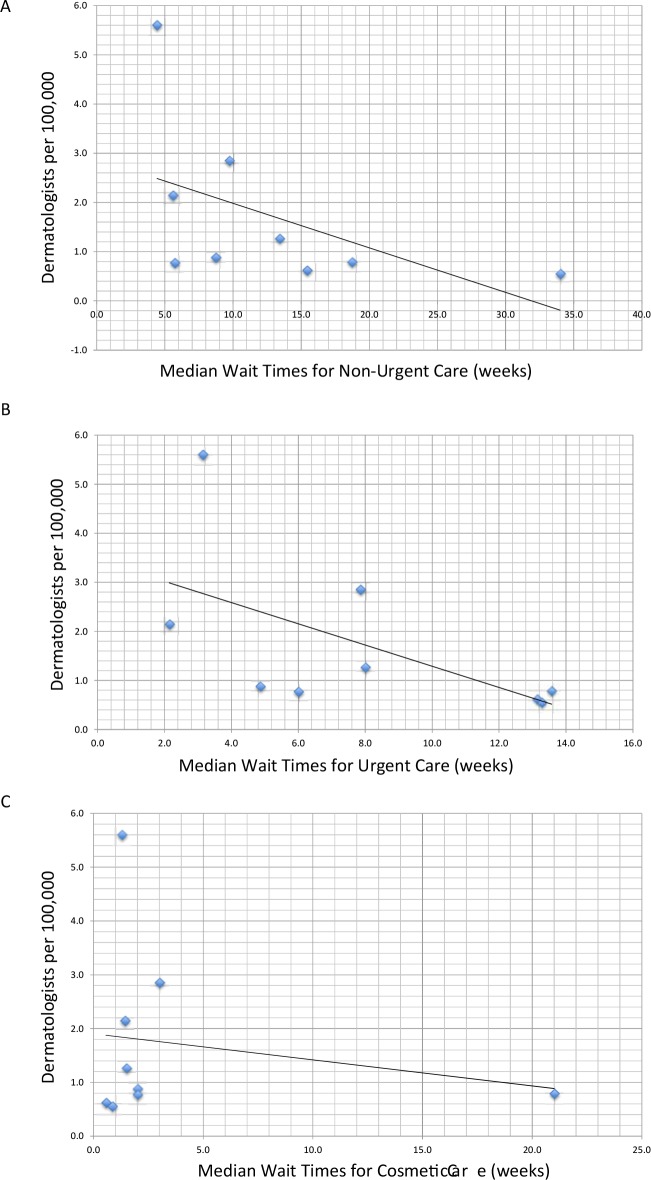
Median wait times for (A) Non-Urgent, (B) Urgent, and (C) Cosmetic care according to the density of dermatologists in each of nine health regions.